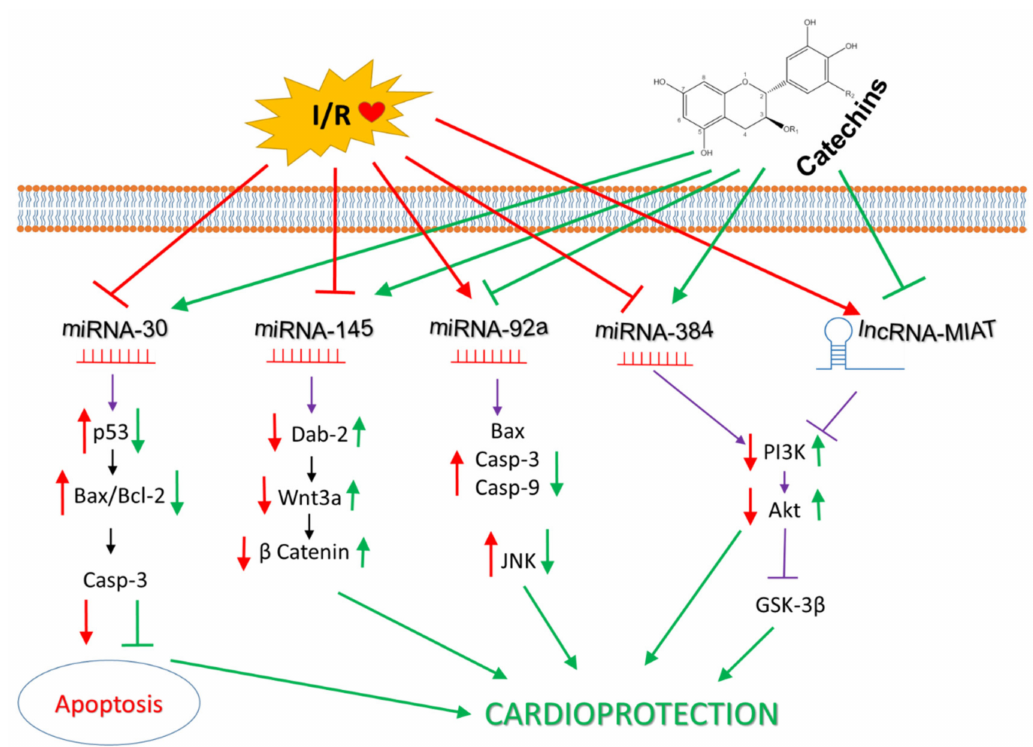
Figure 4. Roles of ncRNAs and associated pathways in cardioprotective effects of catechins in myocardial I/R injury. Abbreviations: Casp-3, caspase 3; Dab-2, disabled homolog-2; Casp-9, caspase-9; PI3K, phosphoinositide 3-kinase; Akt, protein kinase B; GSK-3 β , glycogen synthase kinase 3 beta; lncRNA MIAT, long non-coding RNA—myocardial infarction- associated transcript; Labeling: red arrows—changes due to I/R; green arrows—effects of